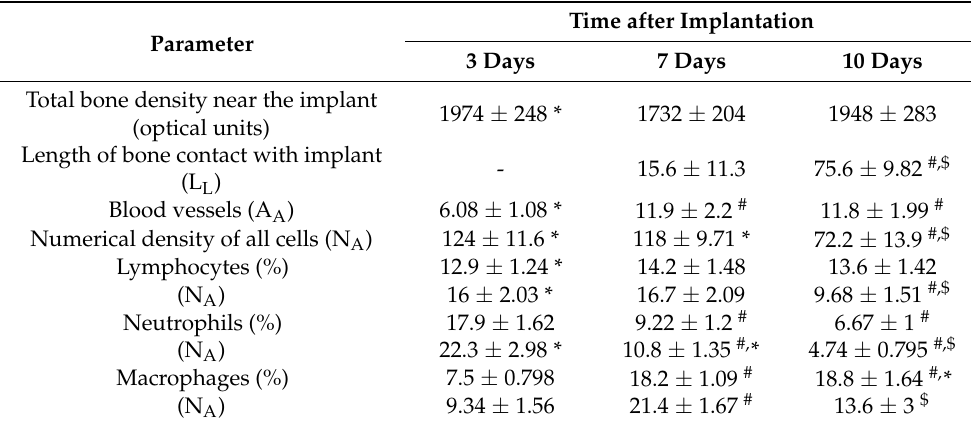
Table 2. Condition of tissues from the proximal tibia condyle near the dental implants after surgery using MSC EVs (S ± σ